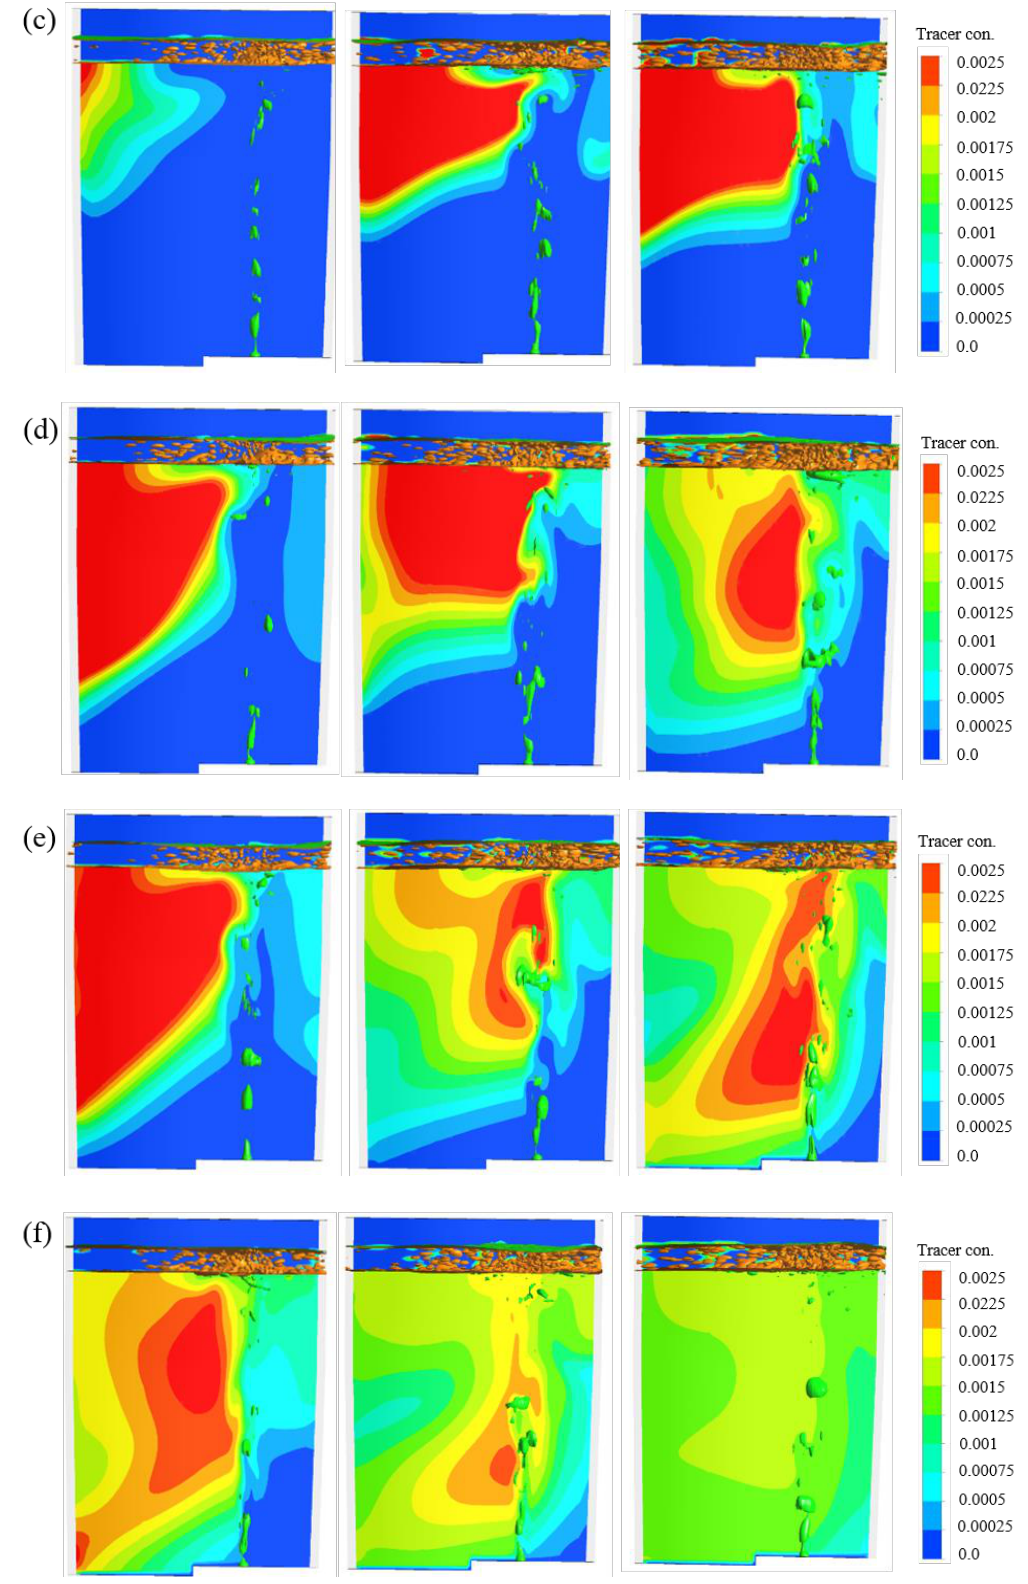
Figure 9. Tracer concentration profiles for di ff erent gas flow rates of 100 (left), 300 (middle), and 500 (right) NL / min with di ff erent time intervals: ( a ) 0 s ( b ) 5 s ( c ) 10 s ( d ) 20 s ( e ) 40 s ( f ) 60